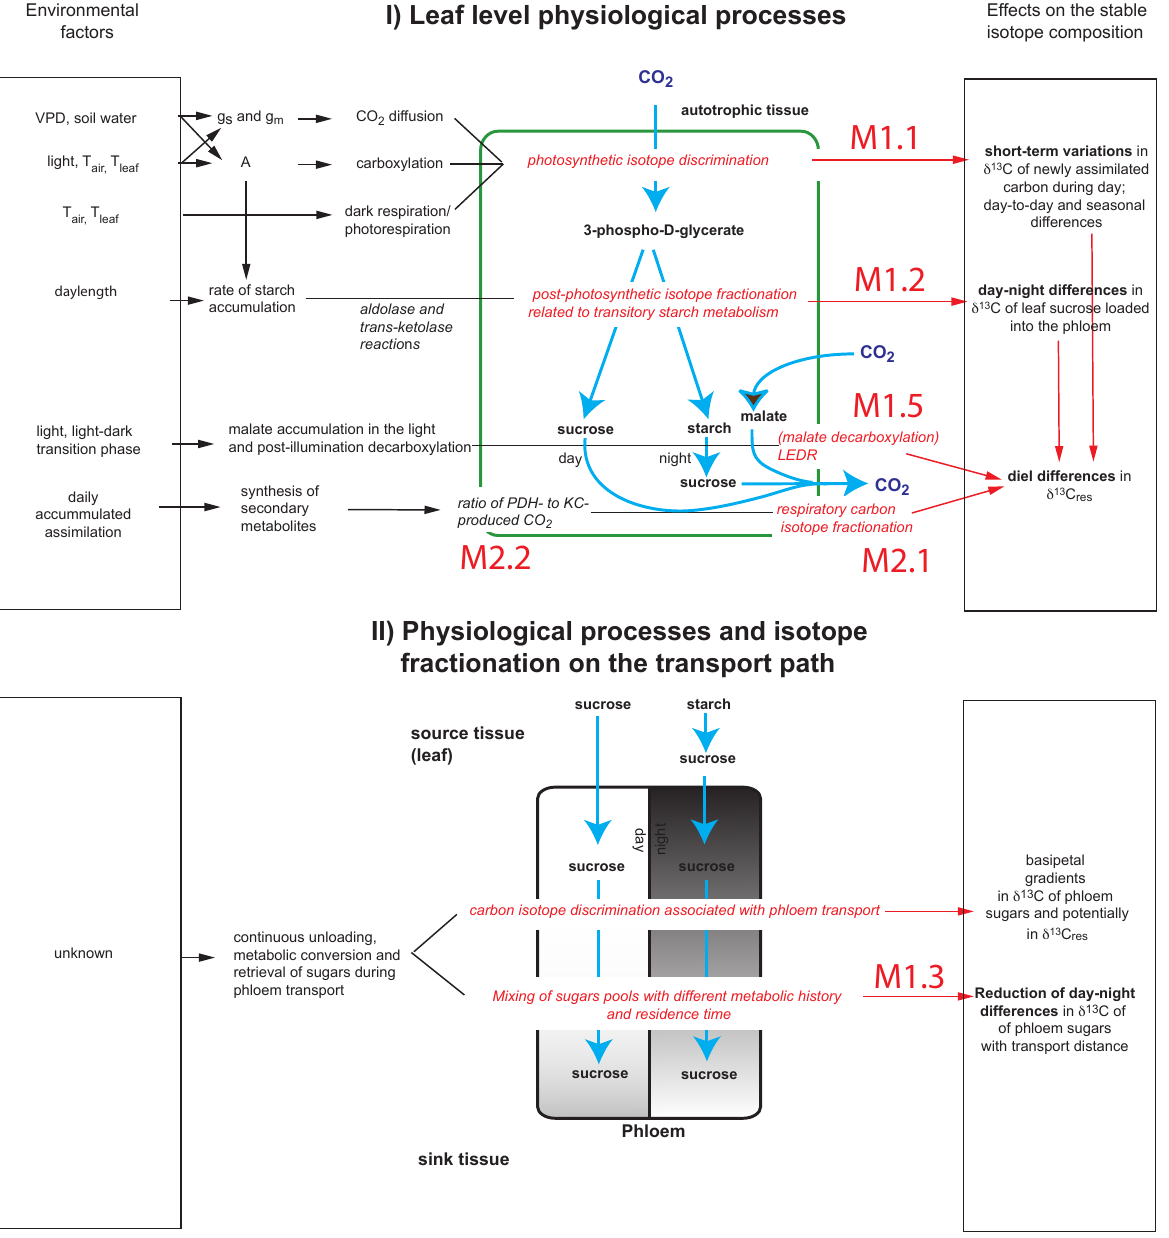
Fig. 2. Physiological processes and isotope fractionations influencing the short-term variation of the carbon isotope signature of organic compounds and in respired CO 2 in leaves (I), on the transport pathway (II), and in the heterotrophic sink tissues (III) of plants. On the left side of the figure environmental factors potentially affecting carbon isotope fractionation processes are listed. In the middle of the figure the processes leading to an alteration of δ 13 C are given in red. On the right side the effects on the carbon isotope composition of organic matter and respired CO 2 are described. The bold blue arrows denote the carbon flux through the plant. VPD, vapour pressure deficit; T air , air temperature; T leaf , leaf temperature; PAR, photosynthetic active radiation; g s and g m , stomatal and mesophyll conductance, respectively; A , assimilation rates. Particular processes and mechanisms are denoted in detail in Table 3 (further information is given in the text): substrate driven variations in δ 13 C res : M1.1: photosynthetic discrimination and potential effects on the diel patterns of δ 13 C of assimilates; M1.2: post-photosynthetic carbon isotope fractionation during transitory starch accumulation; M1.3: dampening of the diel variations in δ 13 C of phloem sugars during basipetal transport, M1.4: switch between respiratory substrates, M1.5: light enhanced dark respiration (LEDR); Isotope fractionation driven variations in δ 13 C res : M2.1: fragmentation fractionation (i.e. fractionation associated with the fragmentation of molecules with non-statistical intramolecular carbon isotope distribution), M2.2: variations of fluxes in the metabolic pathways; M2.3: refixation of CO 2 by